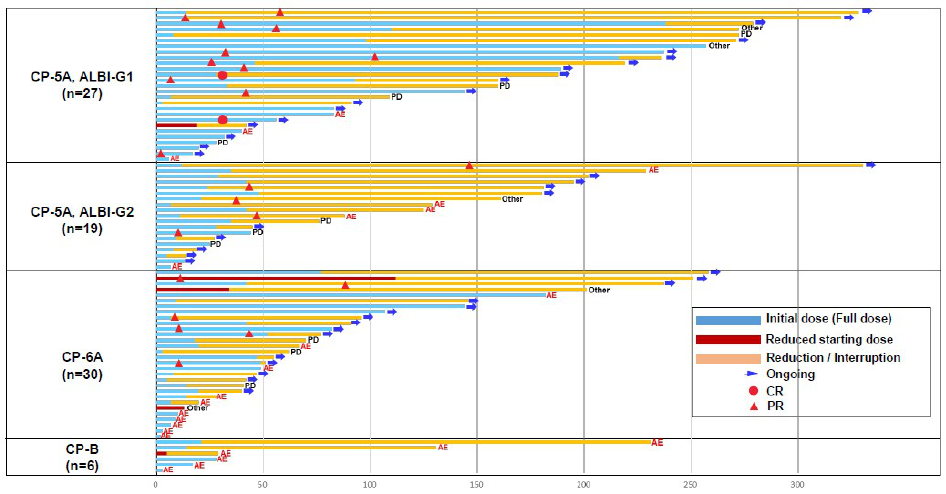
Figure 2. Duration of treatment according to liver function (n = 82).